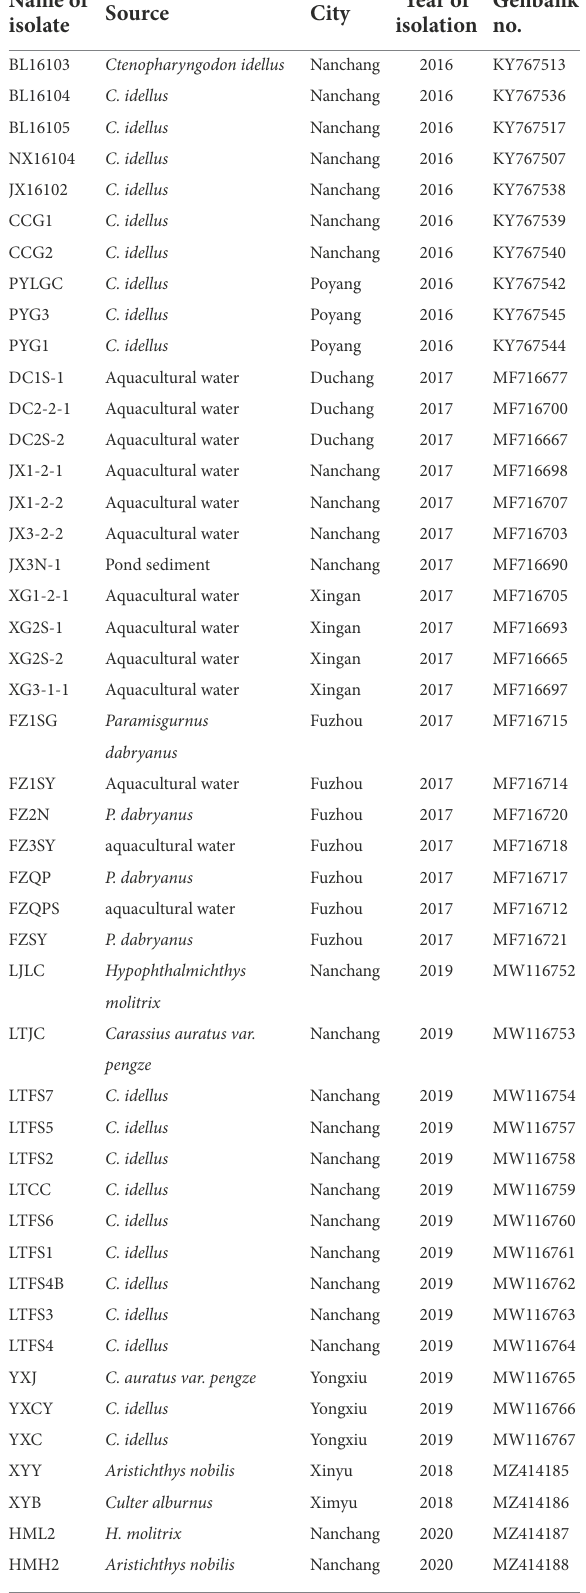
TABLE 1 Characteristics of 46 A. veronii isolates from mariculture systems. Name of